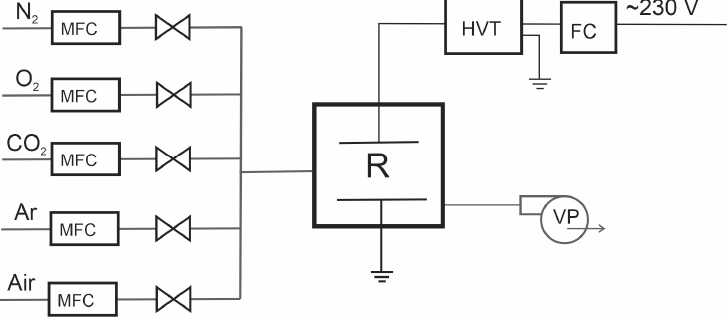
Figure 2. Apparatus diagram. MFC—flow controller, VP—vacuum pump, HVT—high voltage transformer, FC—frequency converter, R—reactor.